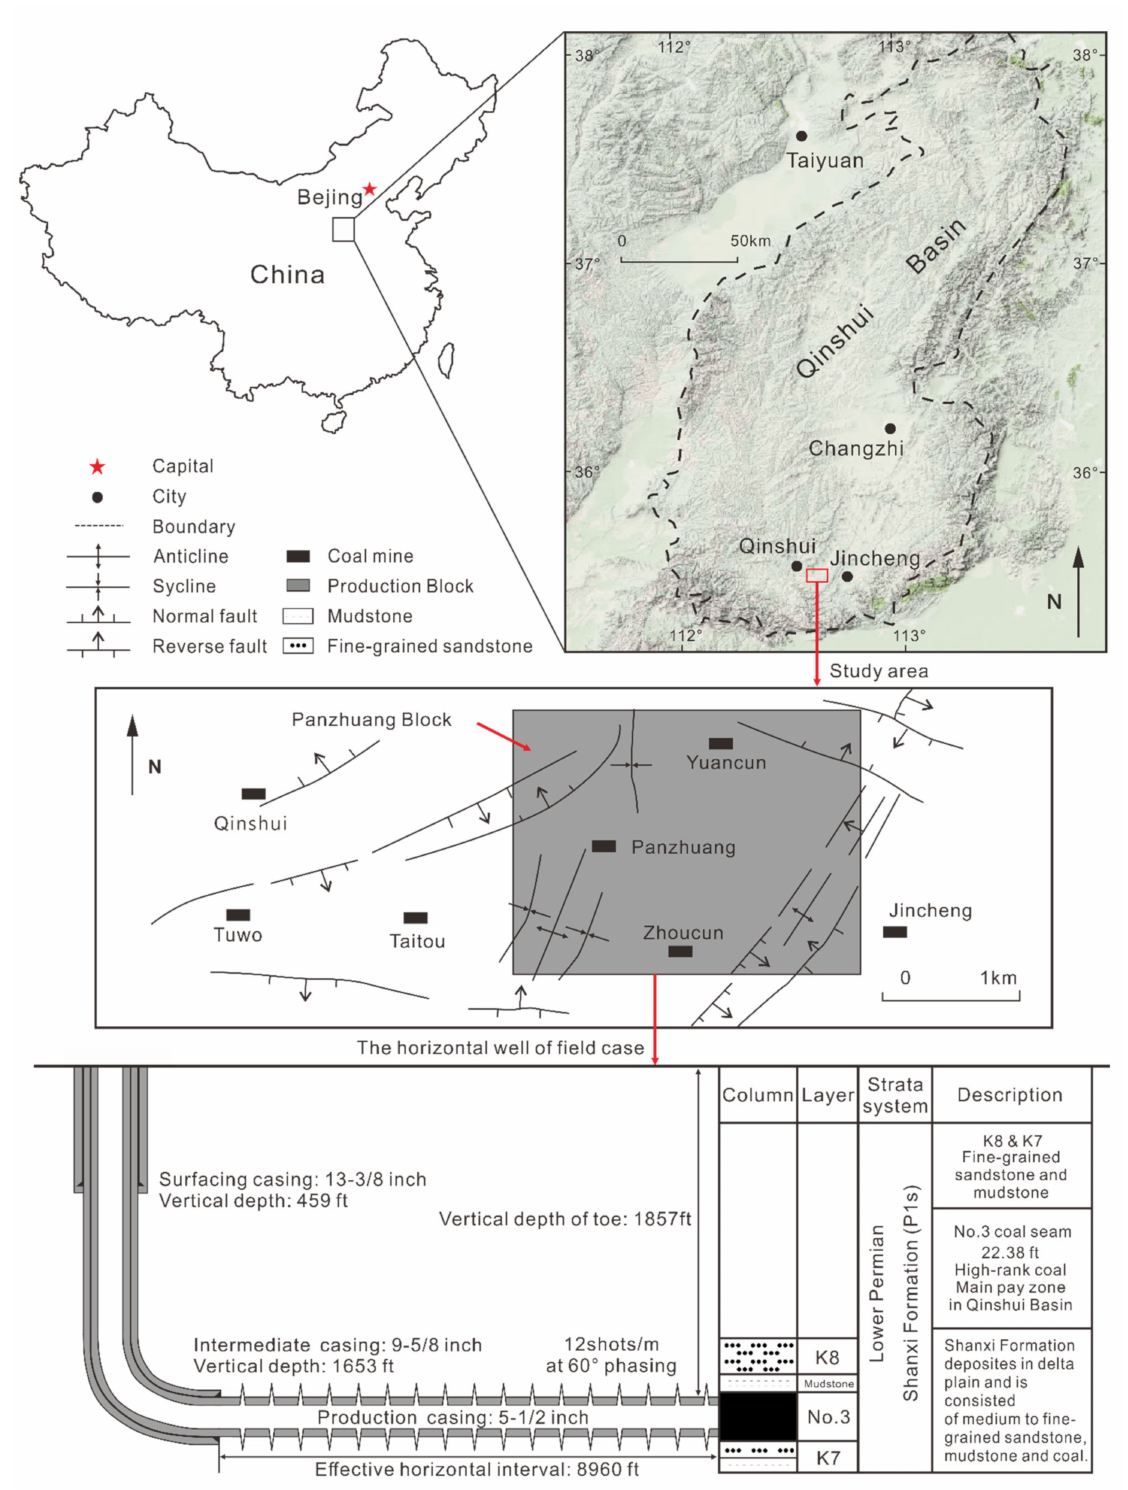
Figure 1. The study area and target horizontal well in the Panzhuang